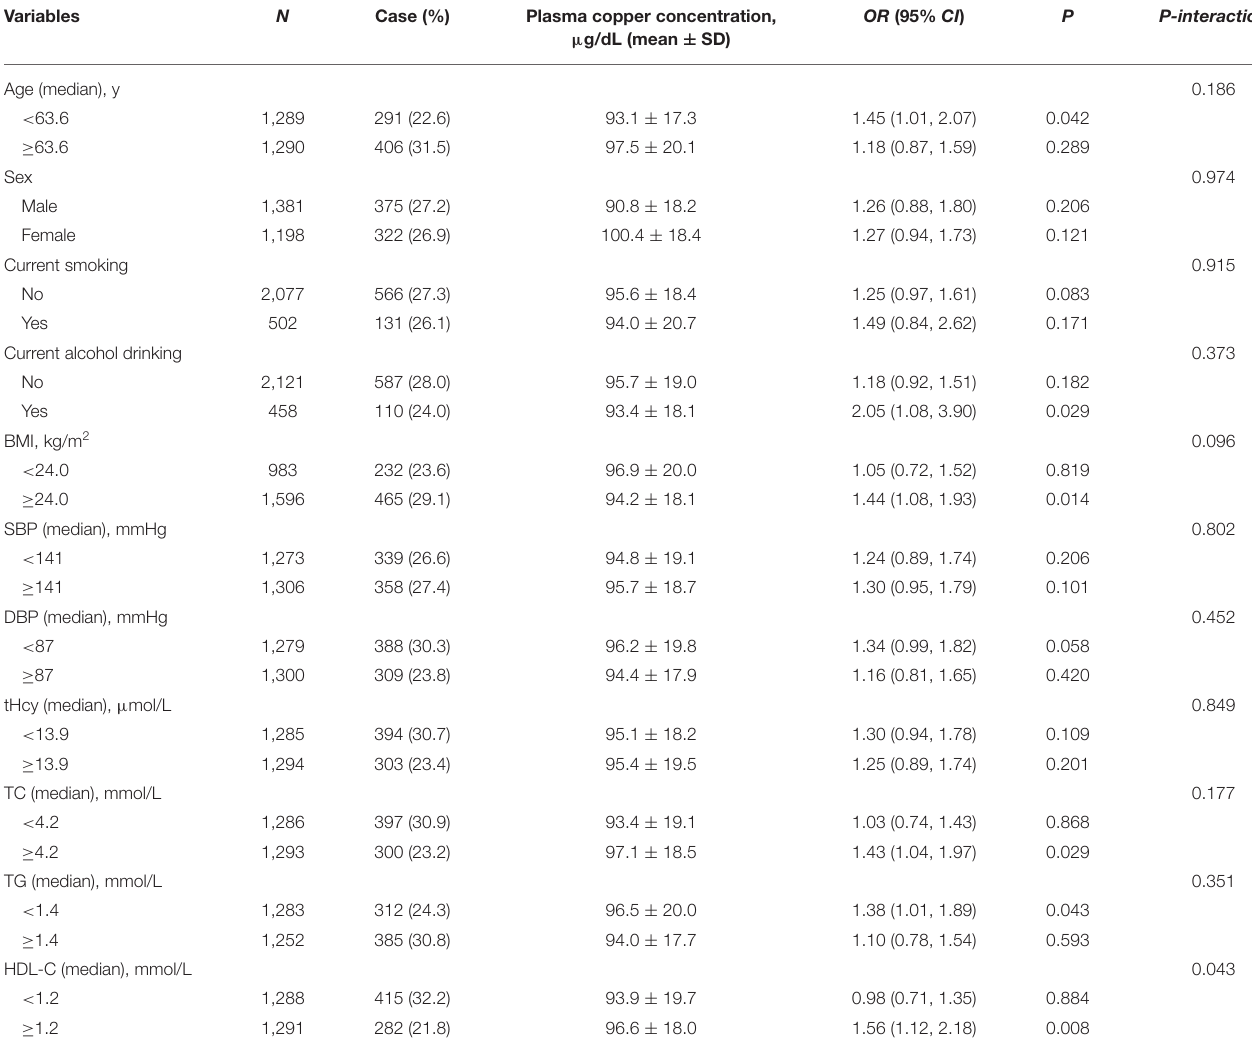
TABLE 3 | Stratified analyses and effect modification on the association between plasma copper concentration and prevalence of diabetes in 2,579 Chinese adults with hypertension a . Variables N Case (%) Plasma copper concentration,